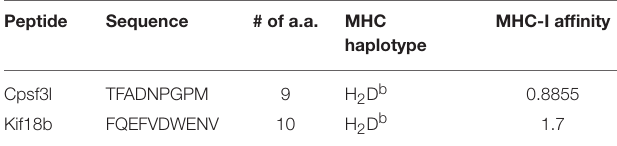
MHC-I affinity haplotype